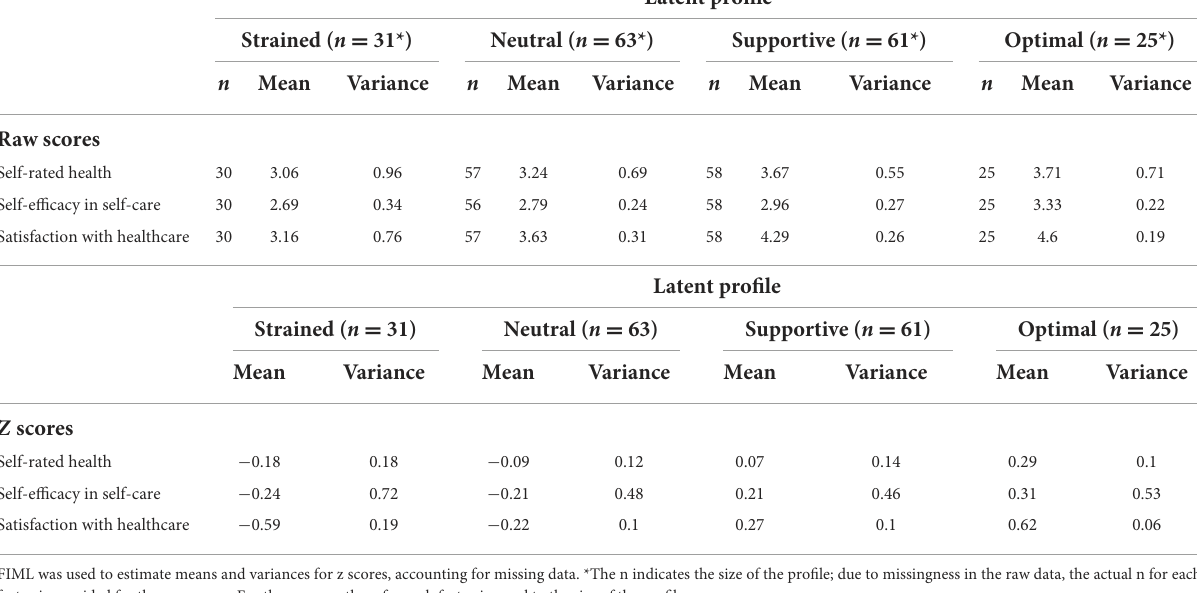
TABLE 7 Means and variances of the raw scores and z scores of exogenous variables at T1 ( N = 180).